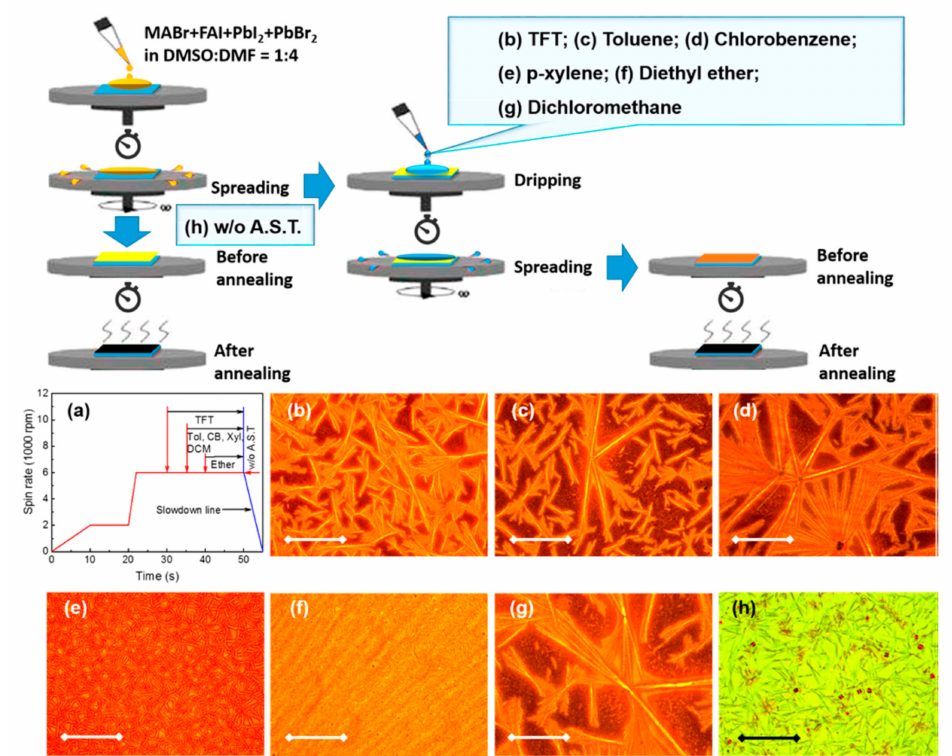
Figure 10. Schematic of fabrication of large crystals by antisolvent method. ( a ) The speed-time profile for the spin coating process with and without the various anti-solvent (A.S.T.) Optical micrographs (OM) illustrating oriented growth of needle shaped crystals with distinct size variation before thermal annealing as a function of various antisolvents with ( b – g ) and without A.S.T. ( h ) Scale bar: 300 µ m. Reproduced with permission from Ref.